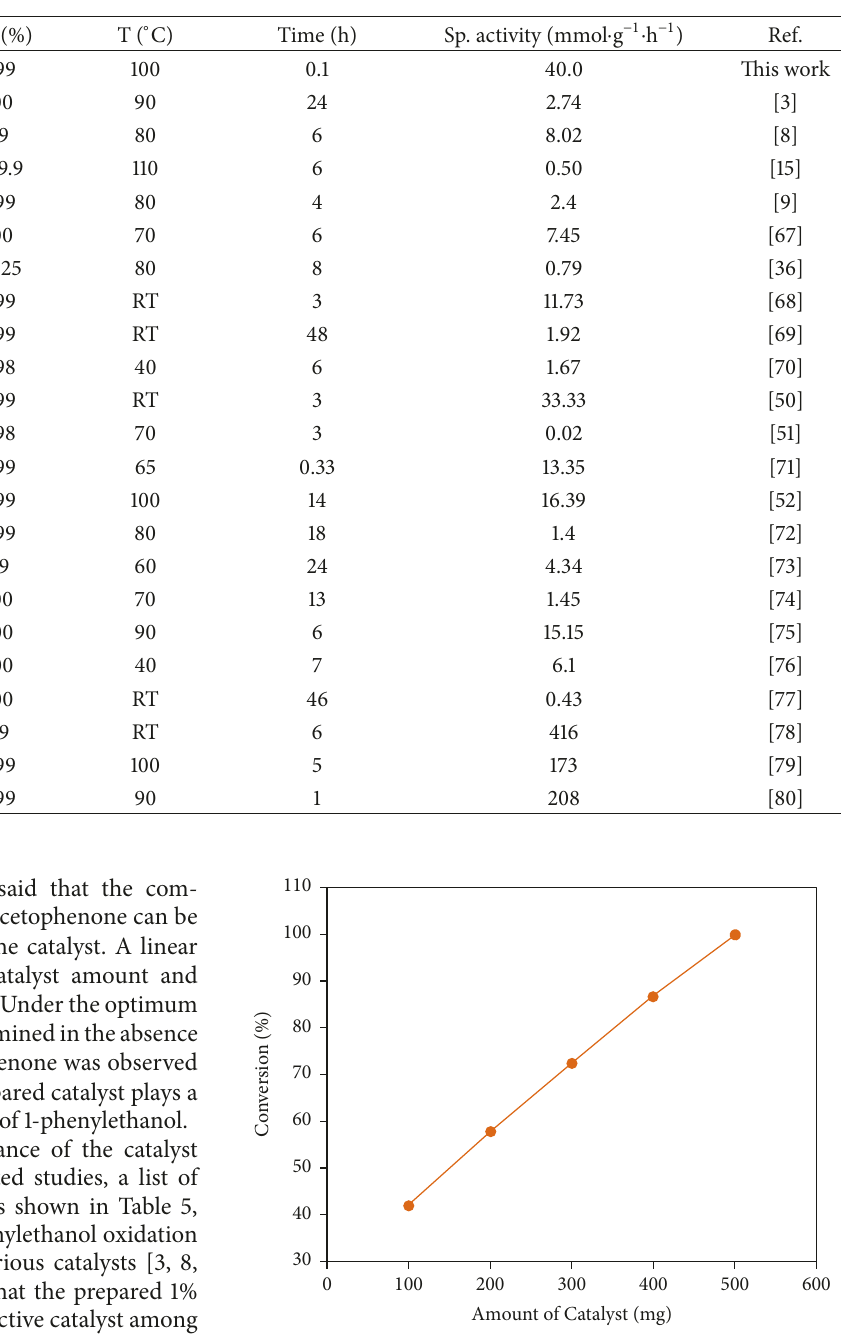
–MnCO 3 catalyst as a func- x